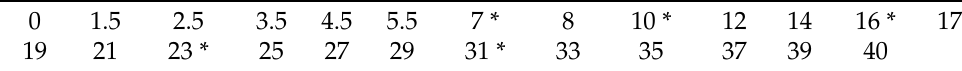
Table 2. Experimentally measured debonding sizes in